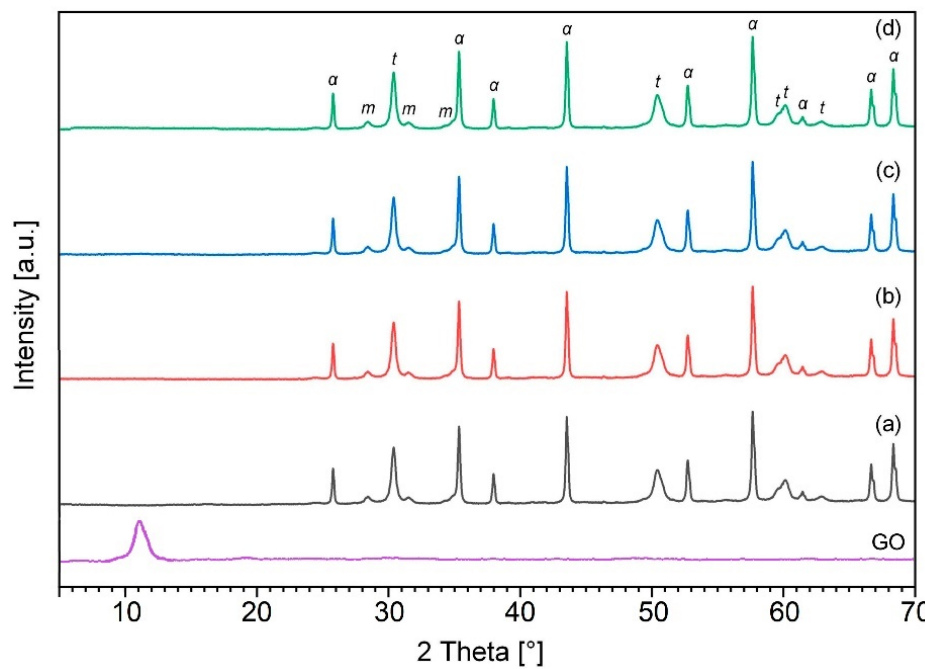
Figure 1. XRD analysis of fabricated GO and ZTA-GO powders after wet ball-milling containing 0 wt.% GO (a); 0.28 wt.% GO (b); 0.52 wt.% GO (c) and 6.1 wt.% GO (d). “ α ”, “ t ” and “m” denote corundum, tetragonal and monoclinic ZrO 2 , respectively.